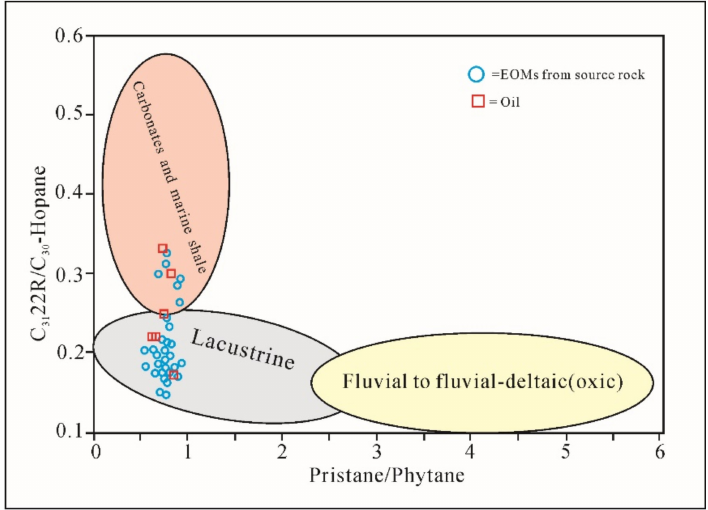
Figure 9. Hopane and isoprenoid ratios of the extracted oil samples, adapted from